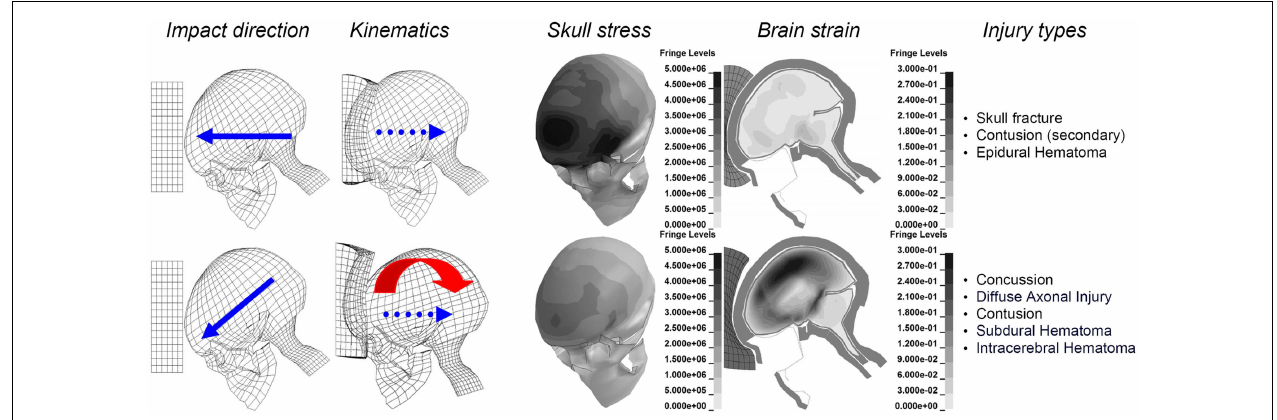
Maximum principal strain (Green-Lagrange) at maximum for the brain are illustrated together with the maximum von Mises stress for the skull bone. Parts of the figure are modified from Kleiven